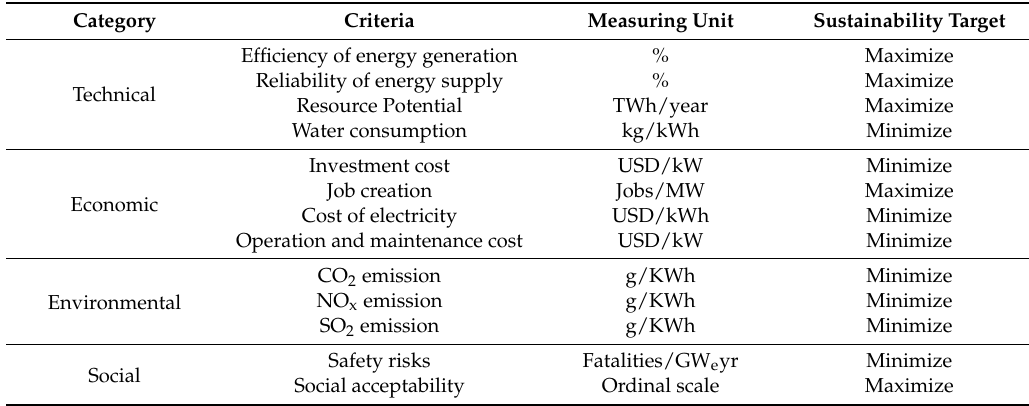
Table 1. The selected assessment